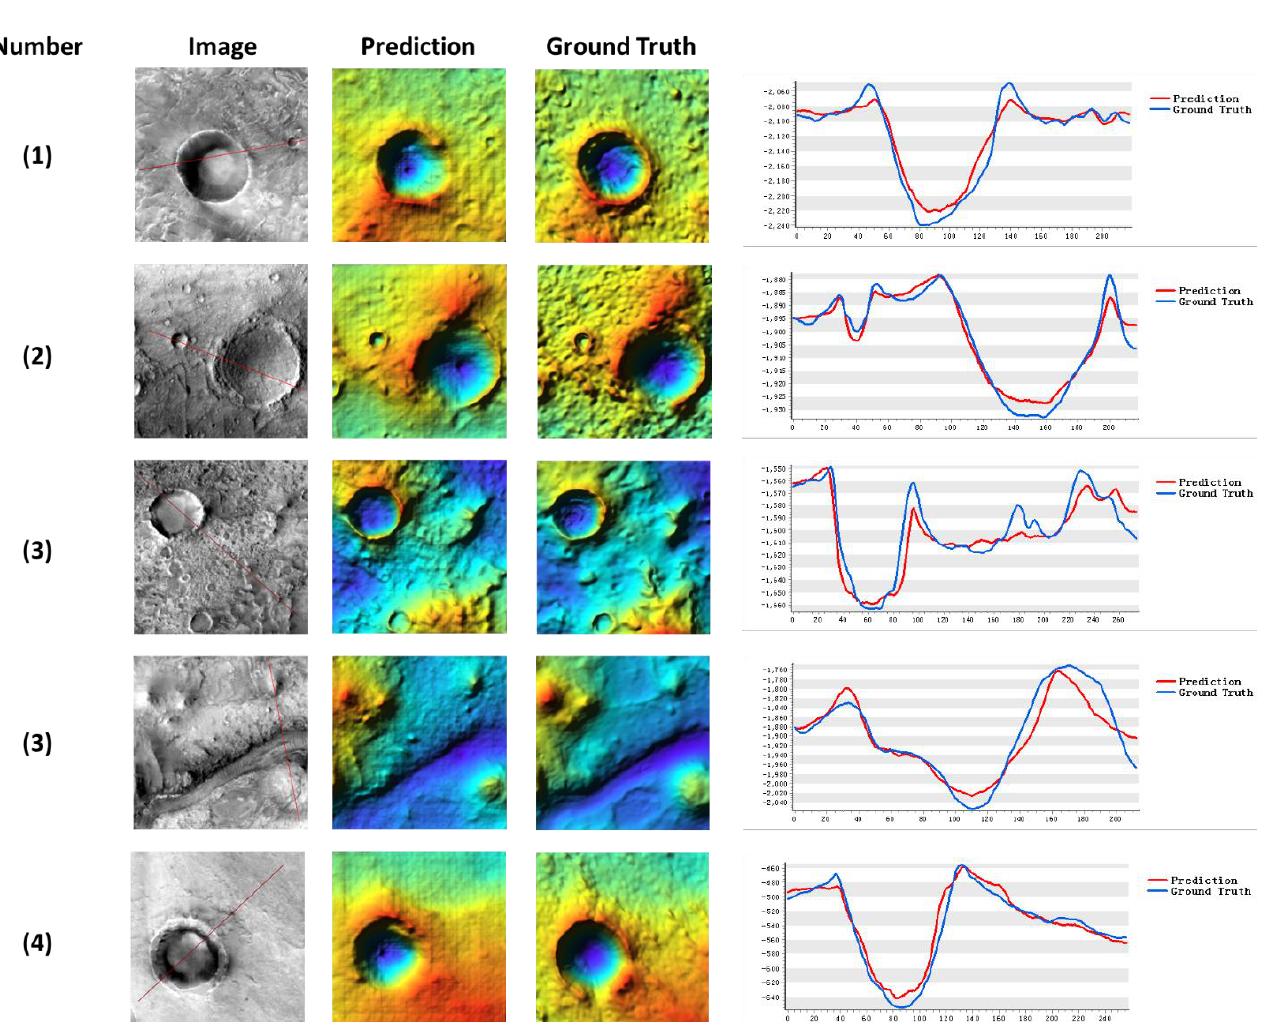
Figure 2. 3D reconstruction results and comparison. Numbers indicate patches selected from the CTX images listed in Table 1. Locations of profiles are depicted on images by red